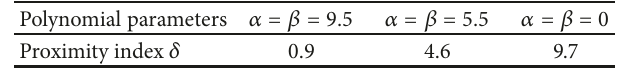
Table 1: Proximity index of the weight functions with different Jacobi parameters for a